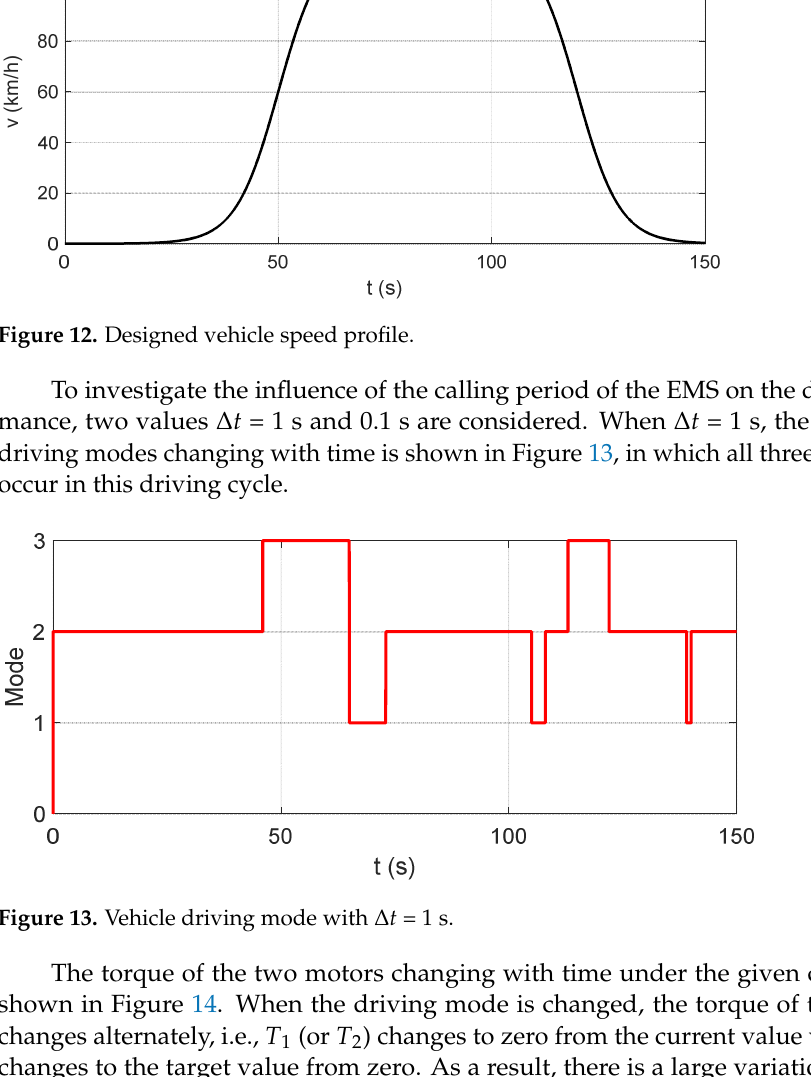
Figure 13. Vehicle driving mode with Δ t = 1 s.